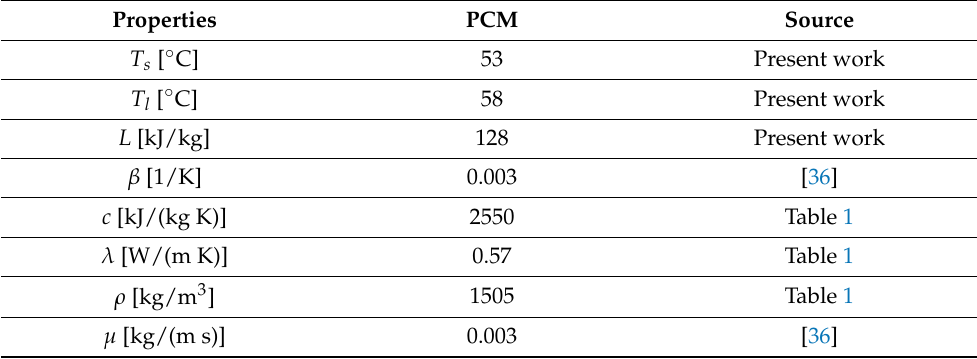
Table 4. PCM parameters used in CFD